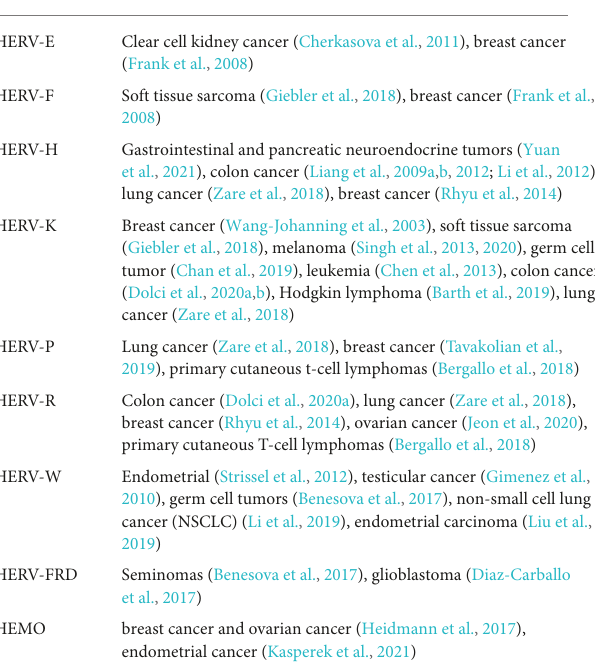
TABLE 1 Expression of HERV families in